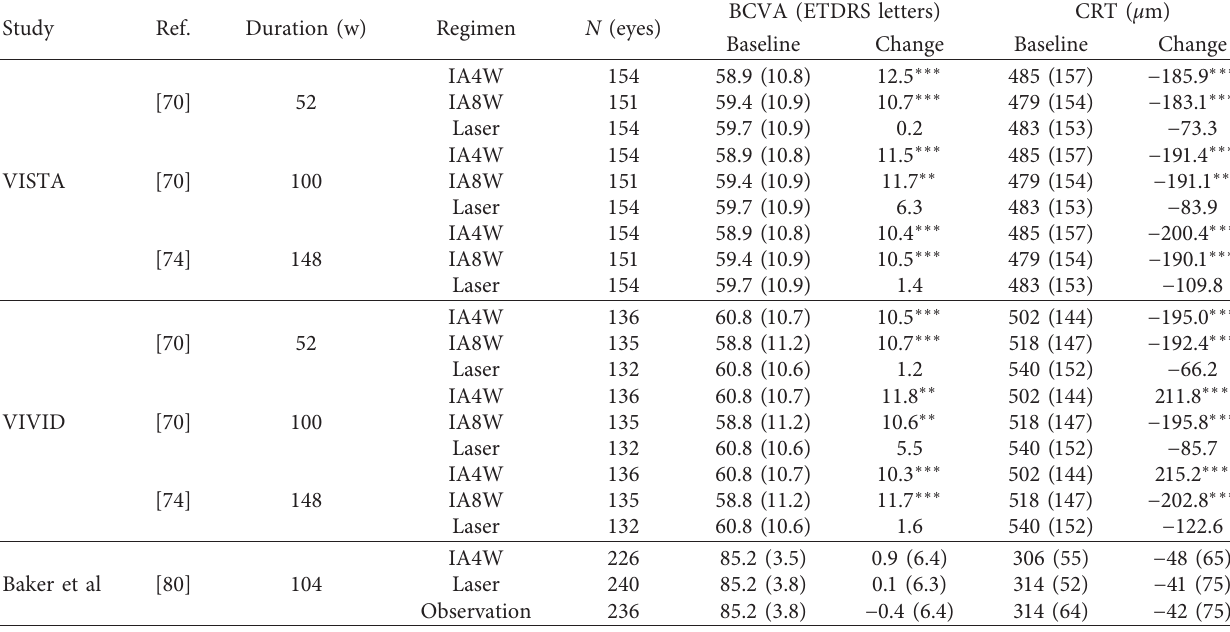
Table 4: Overview of the functional and anatomic results of aflibercept.